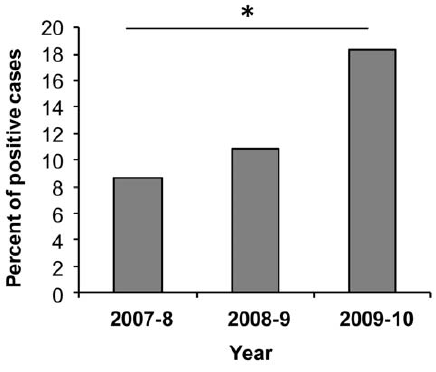
Figure 1. Percent of Hospitalized hMPV patients in Israel. Percent of patients positive for hMPV infections out of patients diagnosed for respiratory virus infections. The patients were hospital- ized in the Sheba Medical Center, Israel, and three winter seasons 2007– 10 are presented.